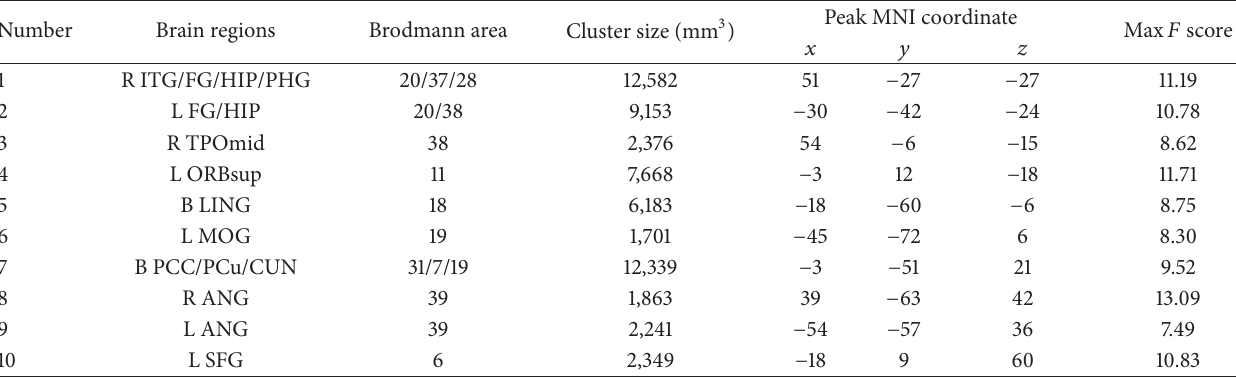
Table 3: Clusters showing significant group effects on